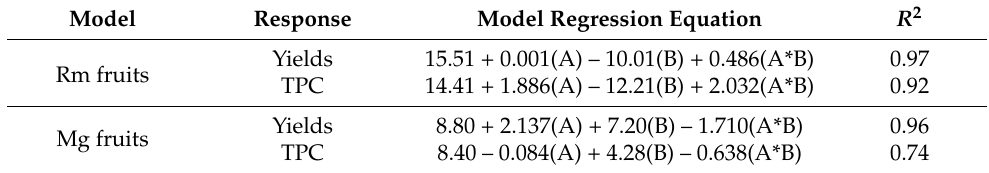
Table 2. Linear models describing the response variation of yields and total phenolic content (TPC) in function of time (A) and solvent (B) tested in experimental models for OH extraction, and their correspondent R 2